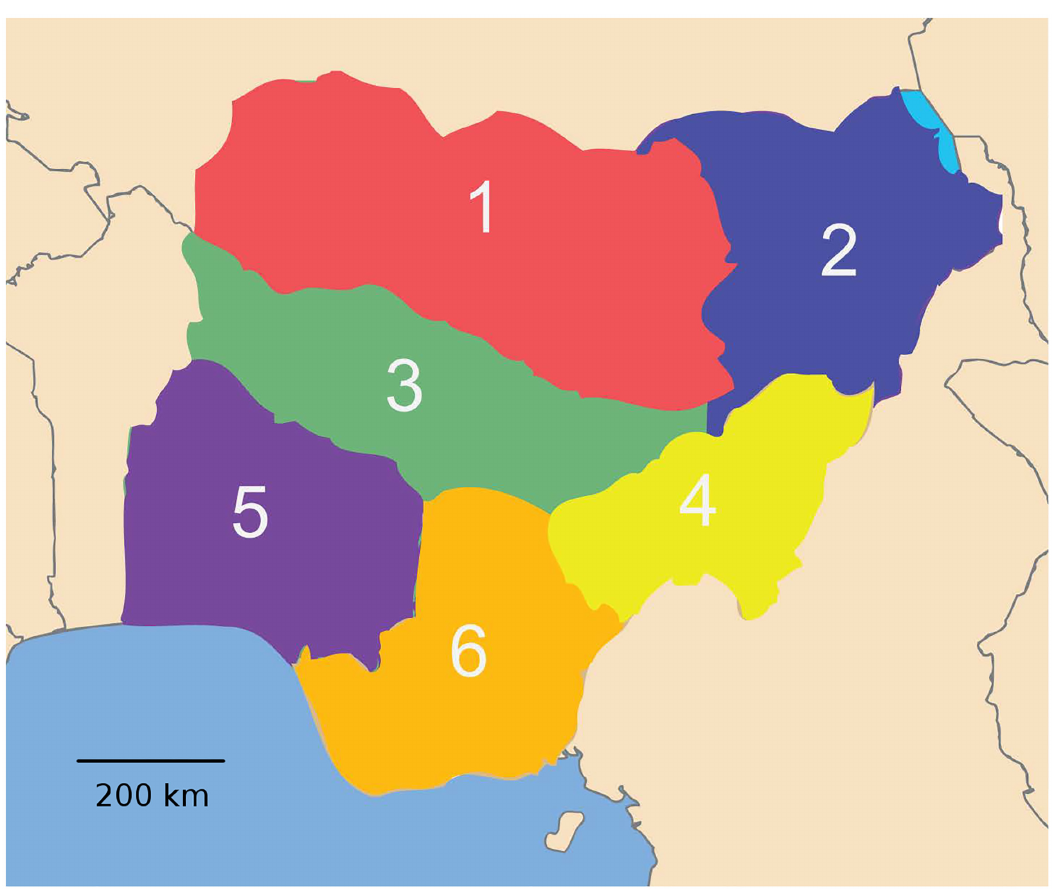
Fig 2. Nigeria was divided into six regions that were used in the experiment design to test for geographic differences for the start of